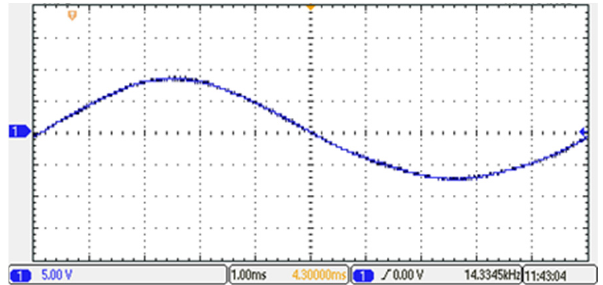
Figure 3. Testing result: the line back-emf of the 3P-HSM.